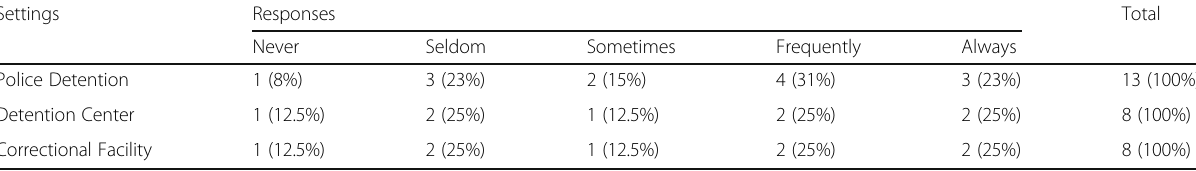
Table 3 Paralegals give information about the clients ’ right to health